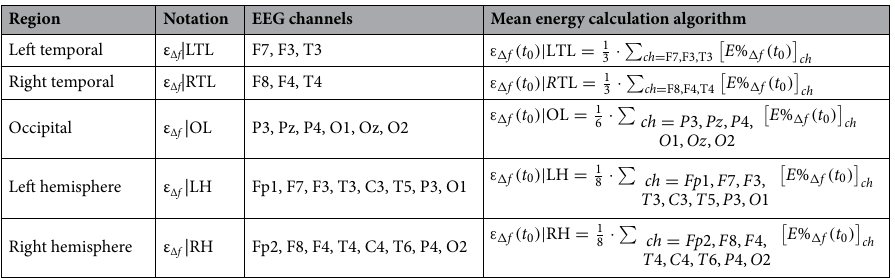
Figure 7. ( a–c ) Present the results of calculating the CWT energy, E in different states—active wakefulness (AW), active sleep (AS) and quiet sleep (QS)—for the EEG channels O2, C4 and Fp2, respectively, recorded during the first monitoring session in a newborn # 7 from group I. The ordinate axes represent the frequencies of oscillatory activity ( f , Hz), while the abscissa axes indicate time ( t , s). The diagram shows a comparative time scale of 300 s. The color codes the mean amplitude of oscillatory activity, where red corresponds to the maximum value, while light yellow color depicts the minimum value.